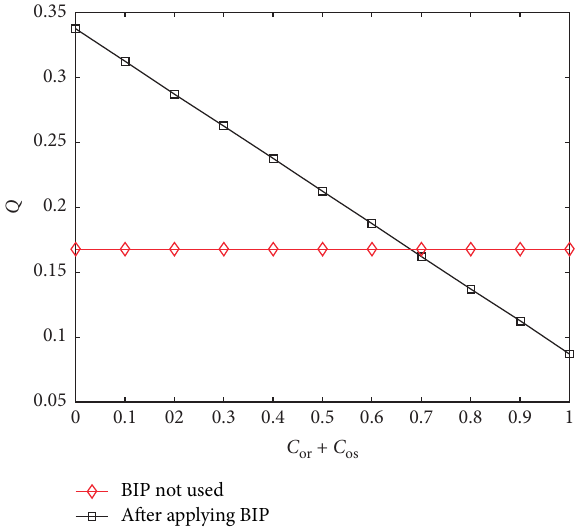
Figure 7: Relationship between fresh food e-commerce order quantity and investment BIP